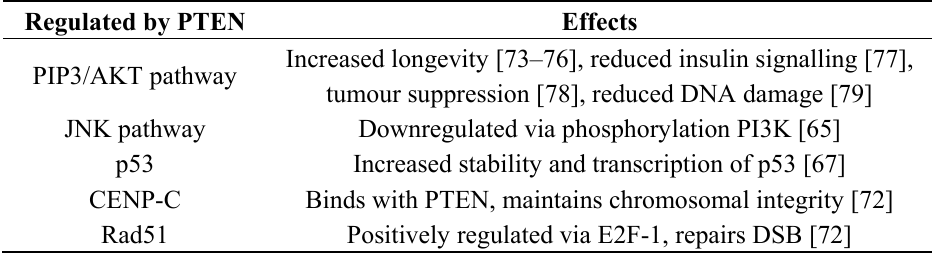
Table 2. The regulatory effects of PTEN.